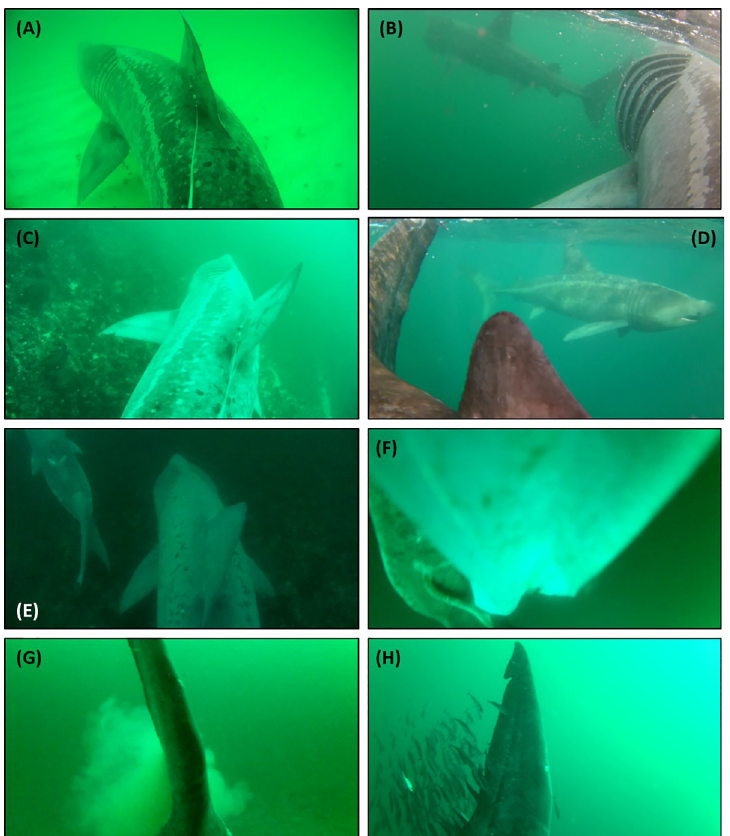
Fig 6. Observed behaviours from towed camera tags. (A) Shark 3 moving over sandy seabed, (B) shark 4 feeding while following a second feeding shark at the surface, (C) shark 2 moving over mixed ground with seaweeds (D) shark 5 trailed closely by a second shark, (E) shark 3 engaged in early morning group behaviour—three sharks visible; instrumented shark (centre) and two other sharks (far left and top right), (F) shark 4 rearward camera obscured